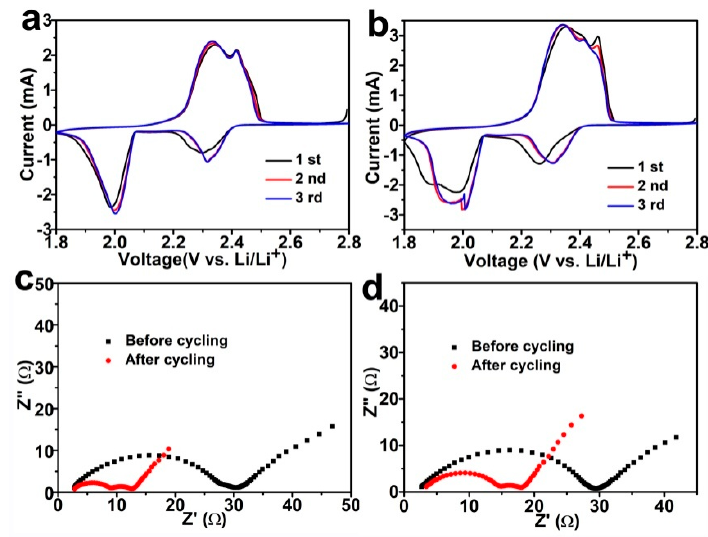
Figure 4. Cyclic voltammetry (CV) curves of Li–S cells using Co 3 O 4 -350 / PI / LLZO separator ( a ) and Co 3 O 4 -500 / PI / LLZO separator ( b ) at room temperature. Nyquist plots of Li–S cells using Co 3 O 4 -350 / PI / LLZO separator ( c ) and Co 3 O 4 -500 / PI / LLZO separator ( d ) at room temperature.